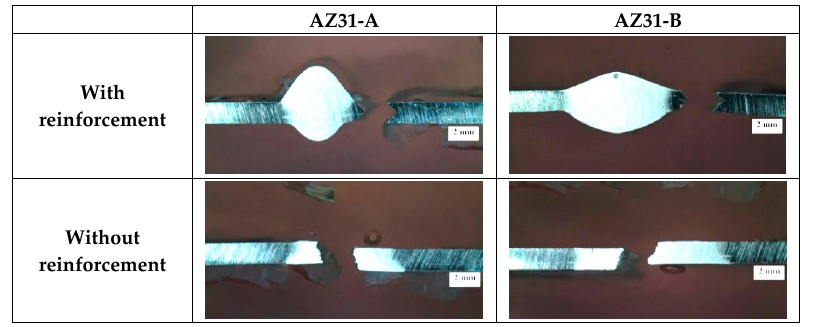
Figure 6. Fractured specimen with and without reinforcement by tensile test.